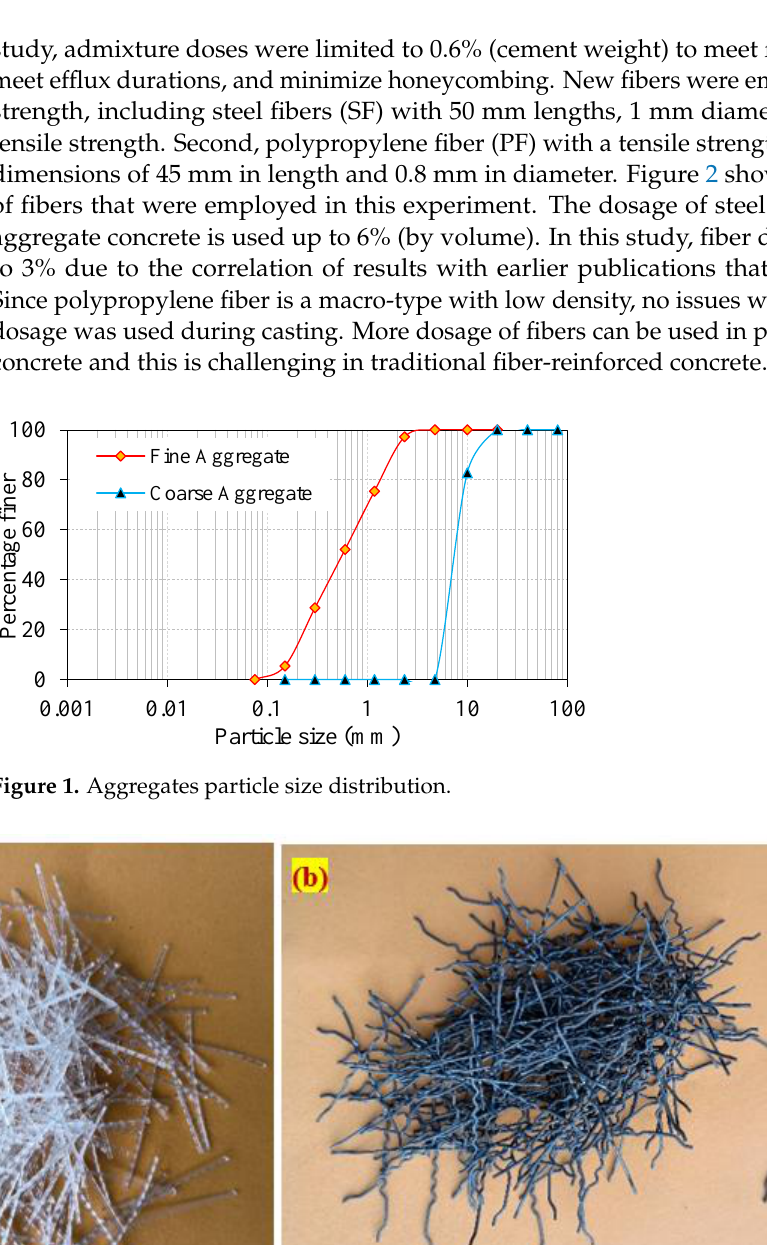
Figure 2. Used fibers in this research. ( a ) Polypropylene; ( b ) Steel.